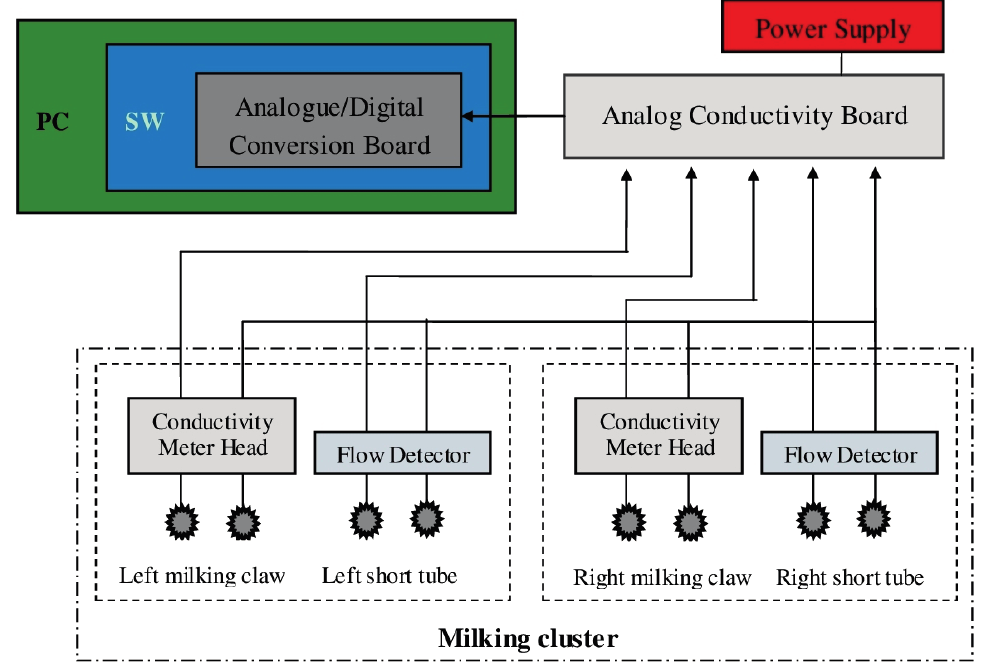
Figure 3. Block schema of the recording system. In the schema only one “analog conductivity board” and milking cluster is reported to simplify the reading of the